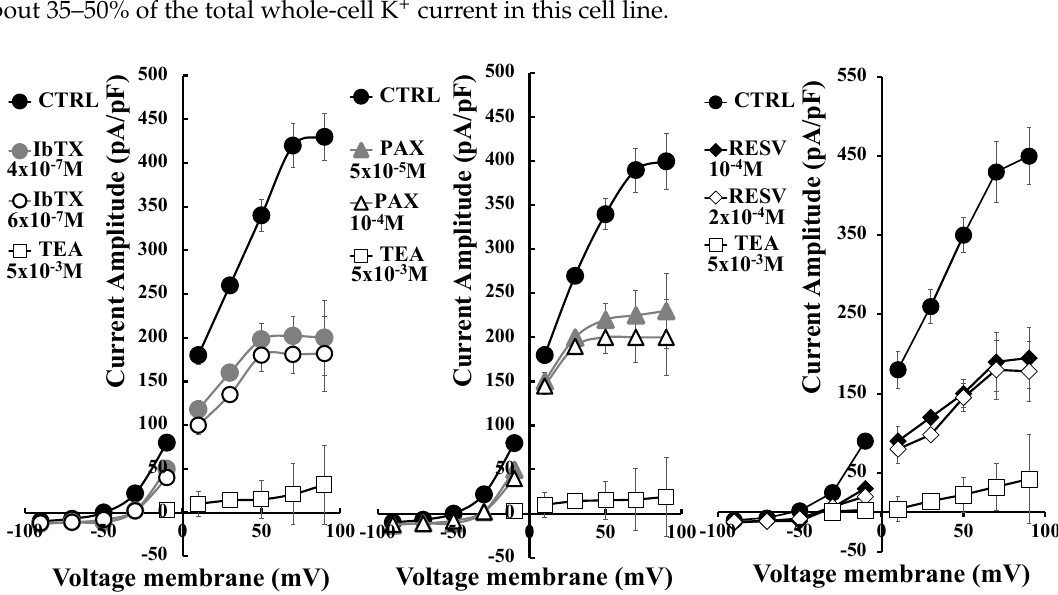
Figure 1. Current-voltage relationship of the whole-cell K + current recorded in SH-SY5Y cells: characterization of the maximal inhibitory effect of the application of the Ca 2+ -activated K + (BK) channel blockers paxilline (PAX) and iberiotoxin (IbTX). A sigmoid I/V relationship of the K + current in a single SH-SY5Y cell recorded in the control condition (CTRL) and in the presence of the specific BK channel blockers PAX at 5 × 10 − 5 and 1 × 10 − 4 M concentrations, IbTX at 4 × 10 − 7 and 6 × 10 − 7